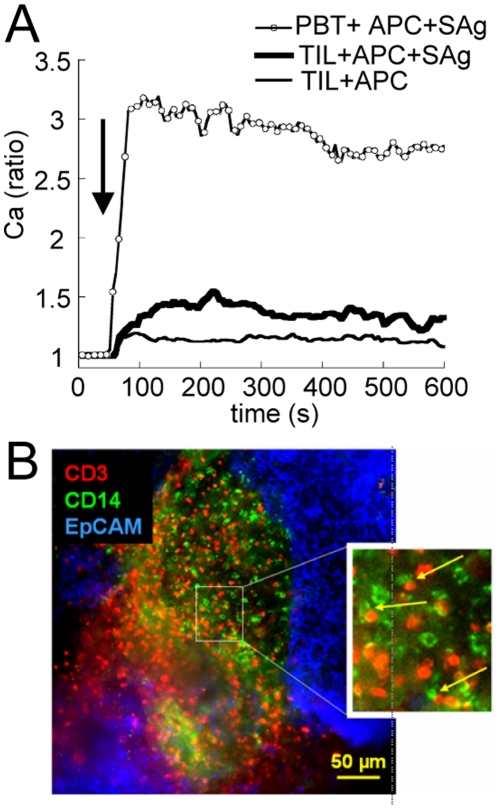
Interactions between TIL and large cells present in the tumor.(A) Average Ca responses triggered in TIL by interaction (arrow) with large cells either unloaded (thin line, average from 7 NSCLC tumors) or loaded with SAg (thick line, n = 6 NSCLC tumors) and in PBT (open symbols, n = 15 cells). (B) A typical triple labelling in a NSCLC slice, of TIL (CD3+ in red), monocytic (CD14+ cells in green) and tumor cells (EpCAM+ in blue). Zoom: arrows point to three CD3+-CD14+ conjugates.